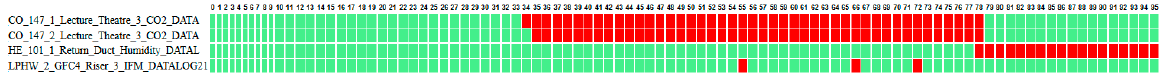
Figure 8. T 2 Signatures of abnormal day, 12 October 2018. Y axis contains the variables and X axis the time. Green represents the variables/time in the model space and red the variables/time out of the model space. The two CO 2 sensors are detected as abnormal. Variables without errors are not represented.